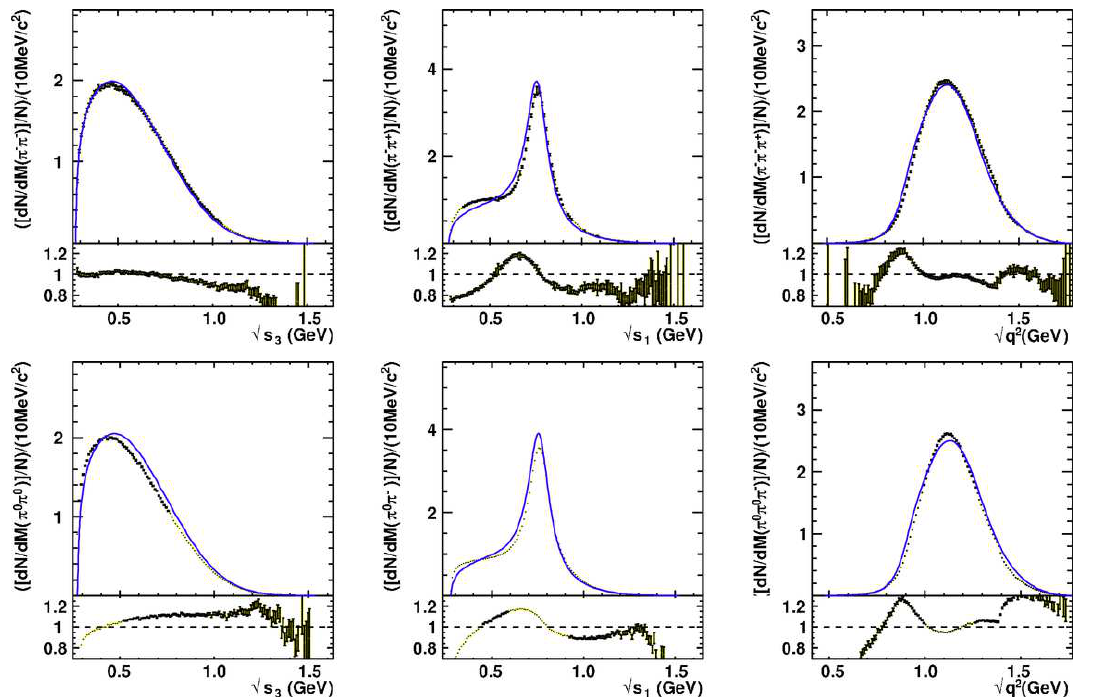
Figure 4 . Top: comparison between the BaBar data and our theoretical prediction for the π − π − π + decay mode. Bottom: comparison between the CLEO ‘emulated’ data (for details the text) and our prediction for the π 0 π 0 π − decay